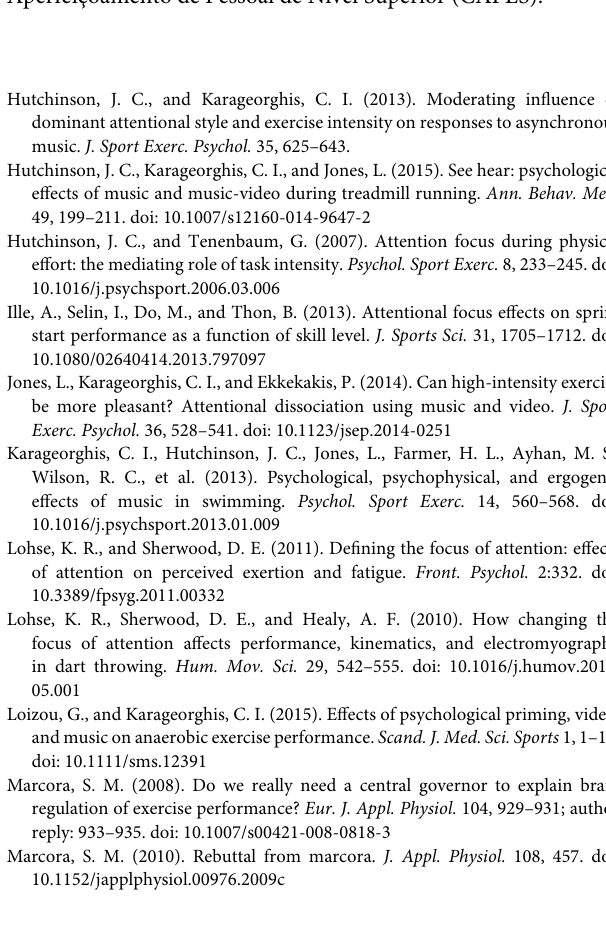
for initiating cascade reactions that underpin the sense of effort and the neural activation to the active muscles. The exercise mode and intensity influence exertional responses over time (Razon et al., 2012). Sensory stimulation/deprivation and attentional strategies (associative or dissociative behavior) can facilitate or jeopardize exercise